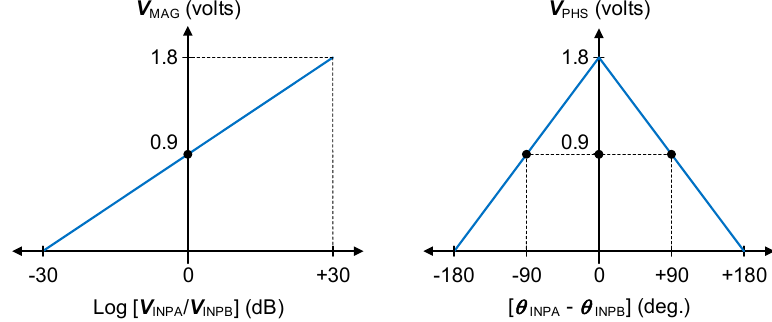
Figure 5. Relationship between magnitude (dB) to the V MAG, and between phase difference (deg.) to the V PHS .